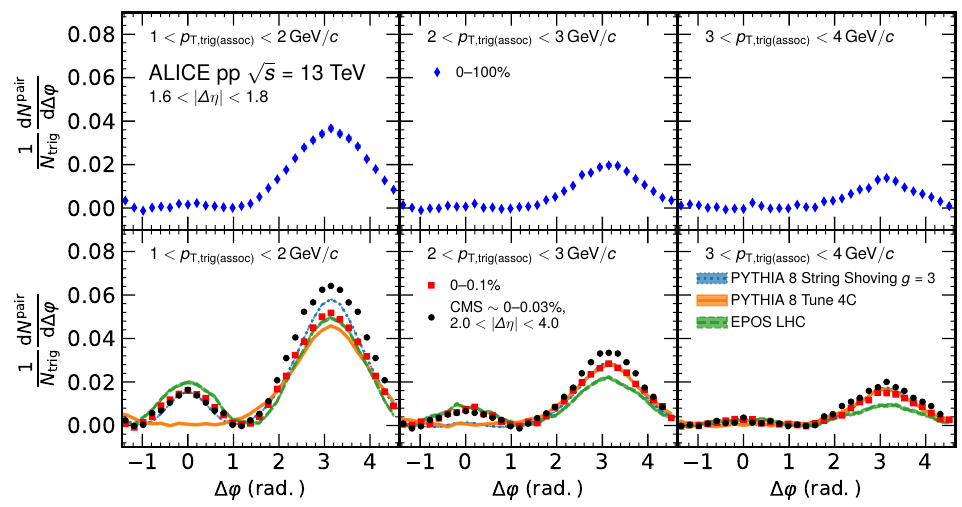
Figure 2 . One-dimensional ∆ ϕ distribution in the large ∆ η projection for three transverse mo- mentum intervals in minimum bias (upper panels) and high-multiplicity (lower panels) events after ZYAM subtraction. Transverse momentum intervals of the trigger particles and associated parti- cles are 1 < p T < 2 (left), 2 < p T < 3 (middle) and, 3 < p T < 4 GeV/ c (right), respectively. The presented model predictions were calculated using PYTHIA 8 String Shoving , PYTHIA 8 Tune 4C , and EPOS LHC